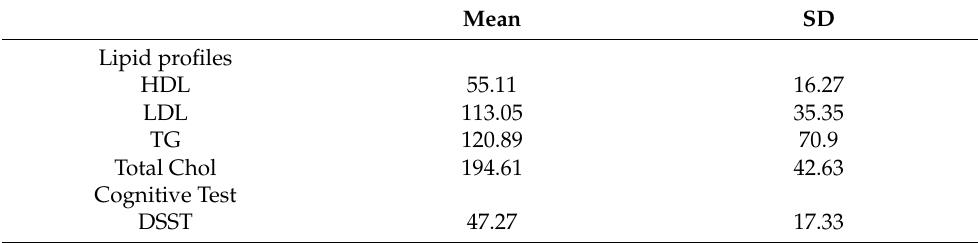
Table 2. Comparison of the means (SD) of lipid profiles and cognitive test score.